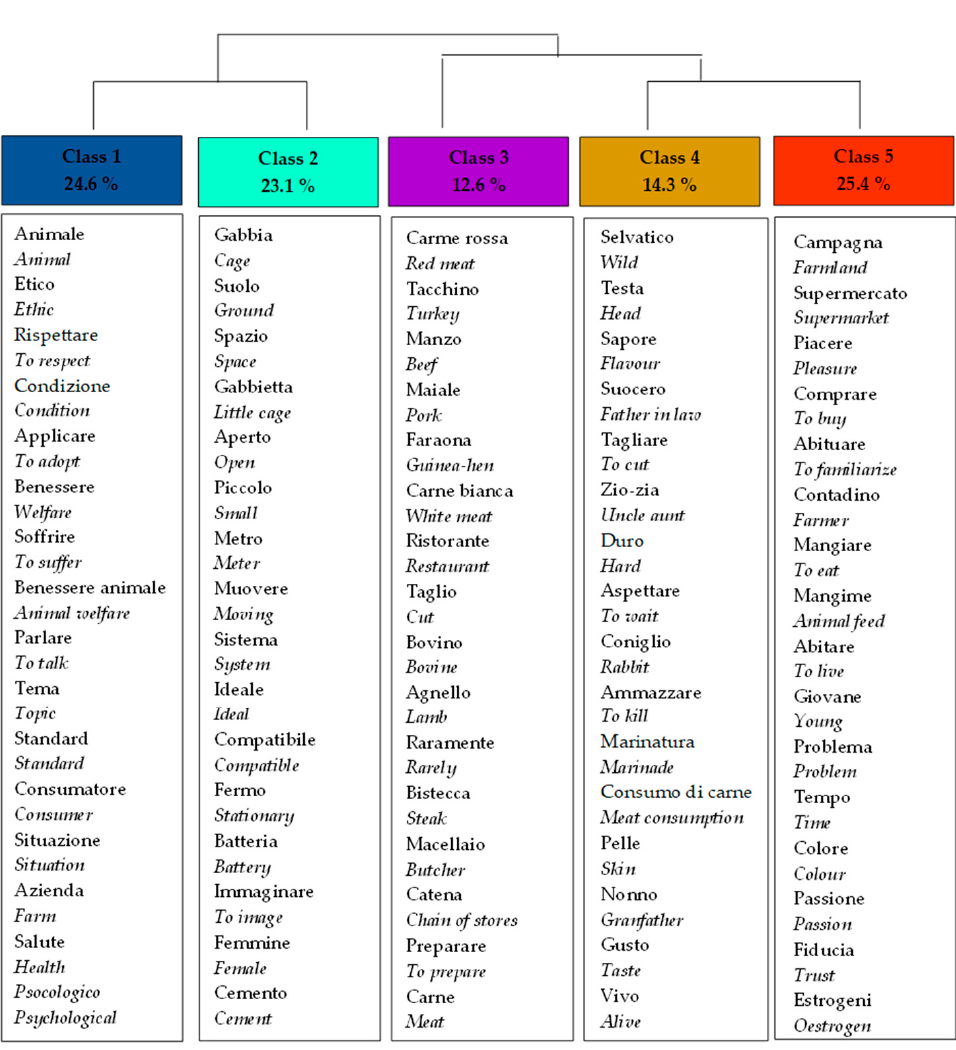
Figure 2. Five clusters of focus group discussions were identified by the Reinert method with the translation of words from Italian to English.